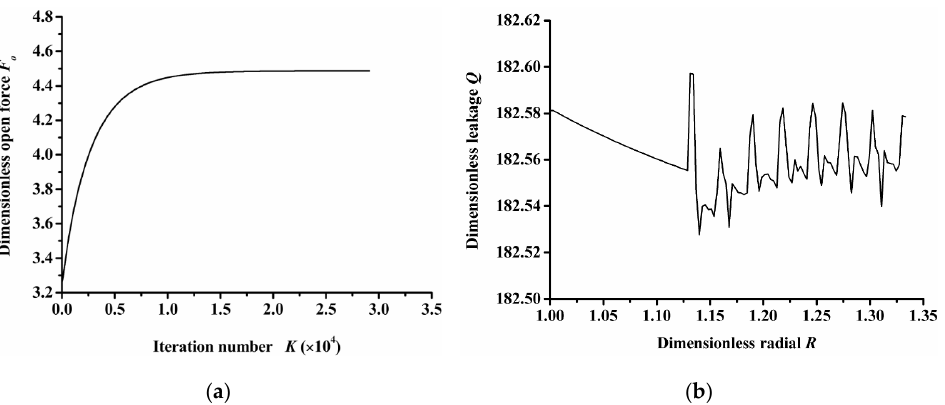
Figure 2. Program convergence verification: ( a ) convergence curve of opening force, ( b ) leakage rate along the radius.